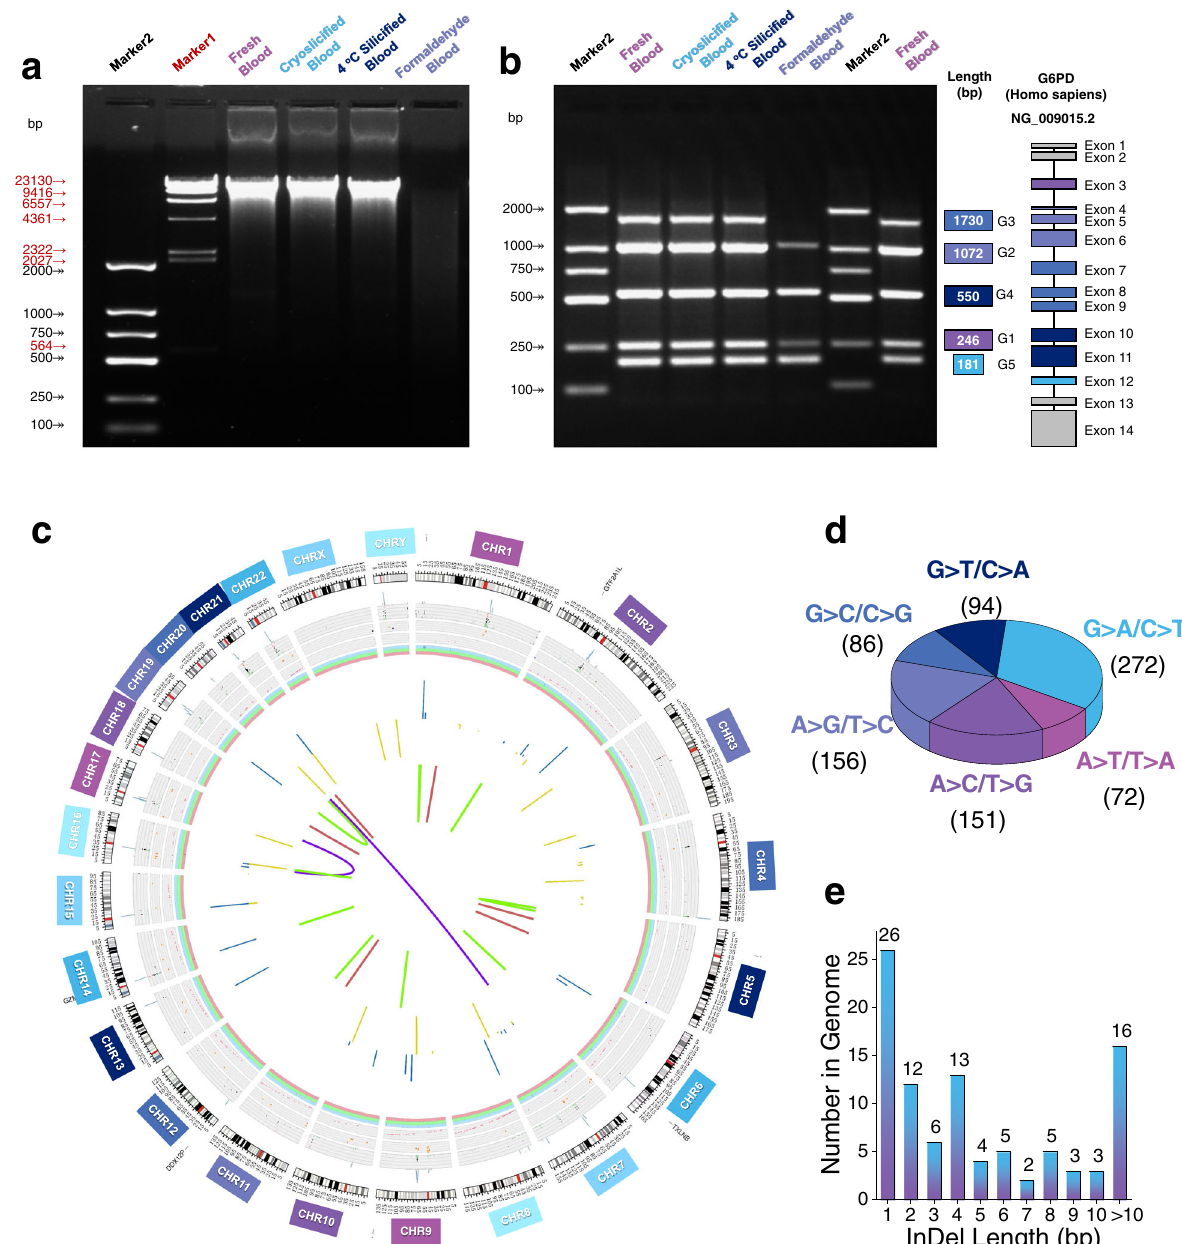
Fig. 3 | Whole blood DNA preservation. a Gel electrophoresis of DNA extracted fromfreshblood,cryosilici fi edblood,4°Csilici fi edblood,andformaldehyde- fi xed bloodsamples.Arepresentativeimageofthreebiologicalreplicatesisshown. b Gel electrophoresis of the ampli fi ed target genomic fragments (G1 – G5) from fresh blood, cryosilici fi ed blood, 4°C silici fi ed blood, and formaldehyde- fi xed blood.